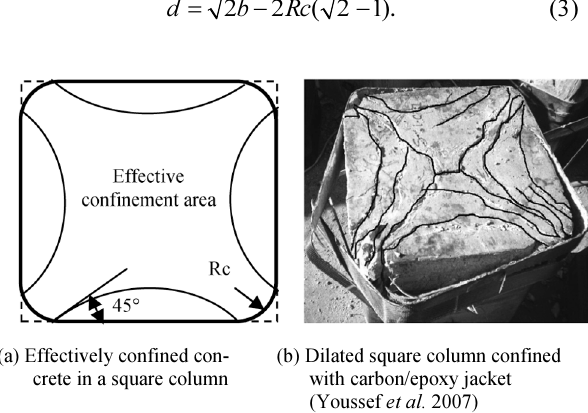
Fig. 2. Confinement action of FRP composite in square